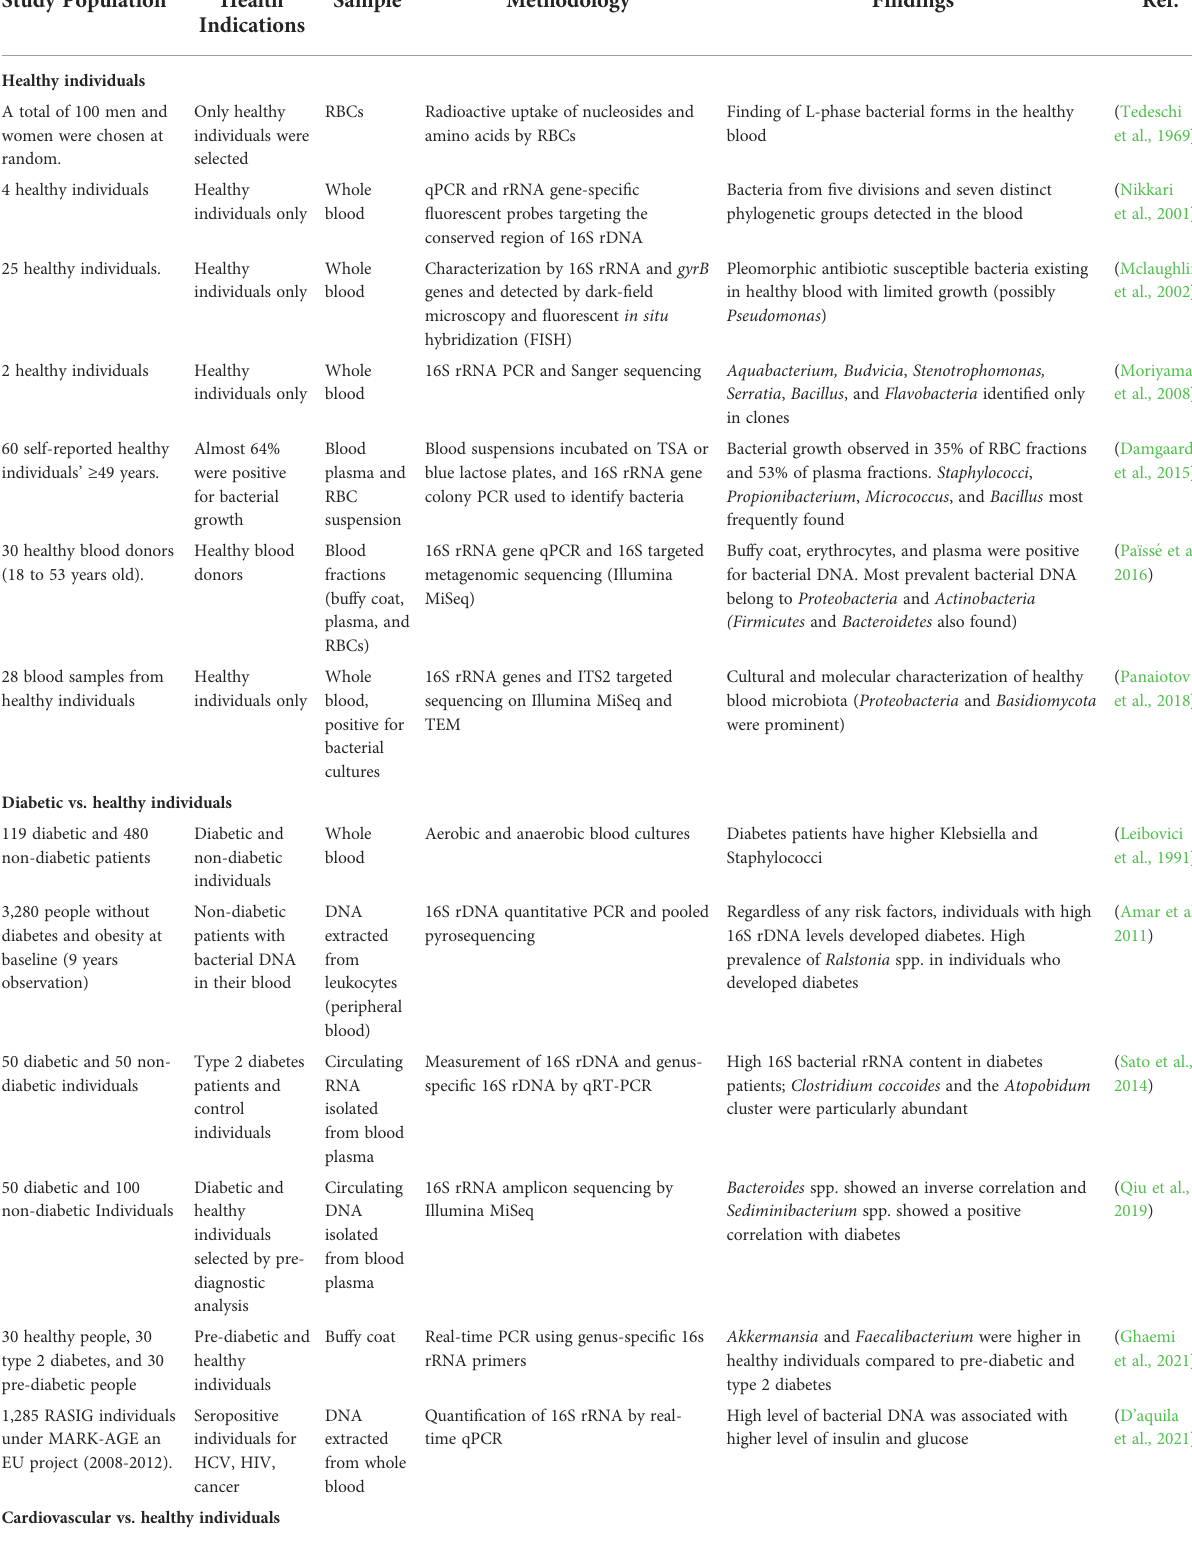
TABLE 1 Summary of different human blood microbiota studies conducted on healthy or diseased